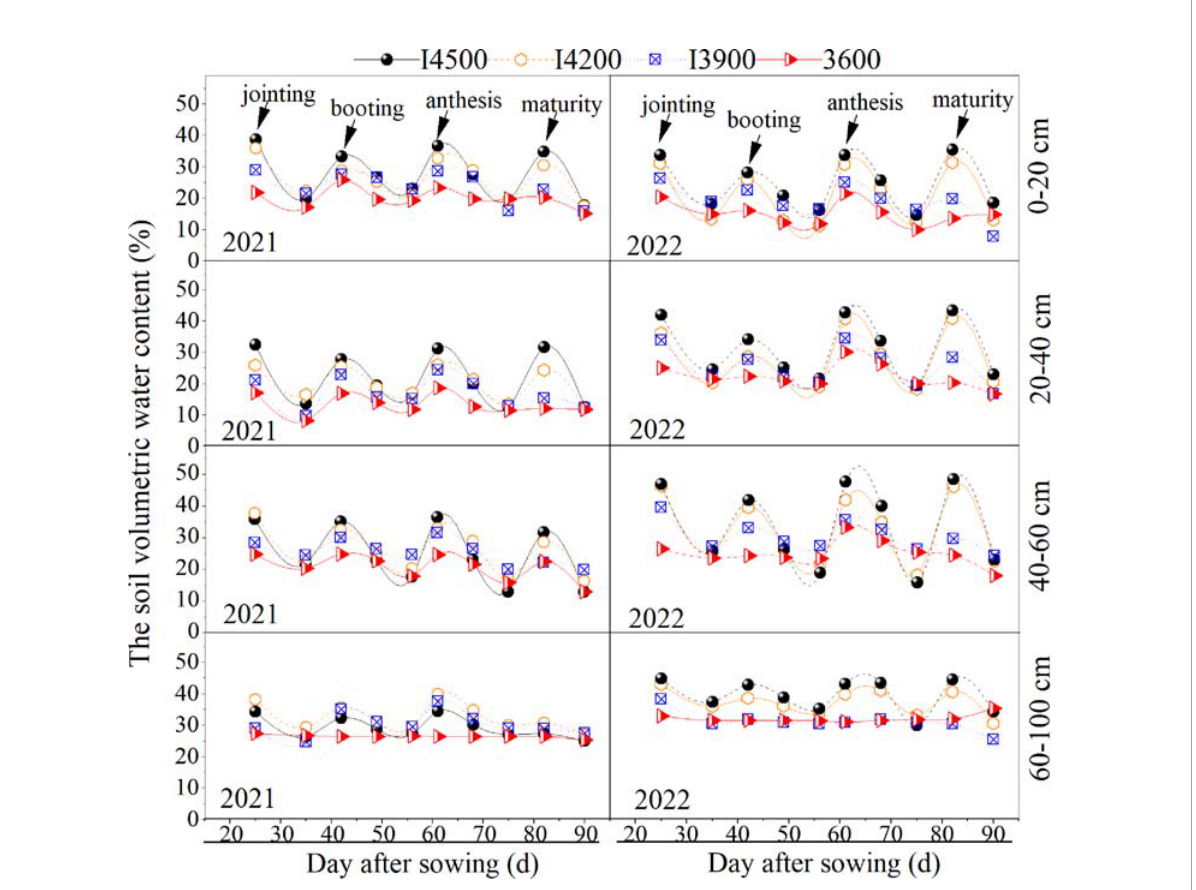
FIGURE 5 Volumetric water content in the soil during the various wheat growth stages. I4500, I4200, I3900, and I3600 indicate 4500, 4200, 3900, and 3600 m 3 ha − 1 irrigation levels,